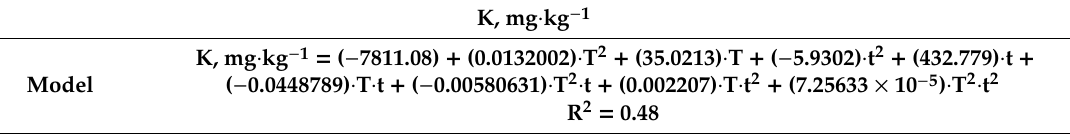
Table A17. The statistical parameters of polynomial regression analysis of the influence of SS torrefaction temperature and residence time on the K content in